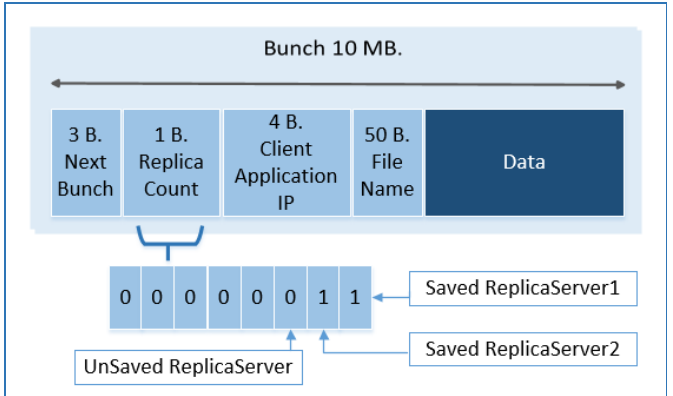
Figure 5. Bunch structure of file system.